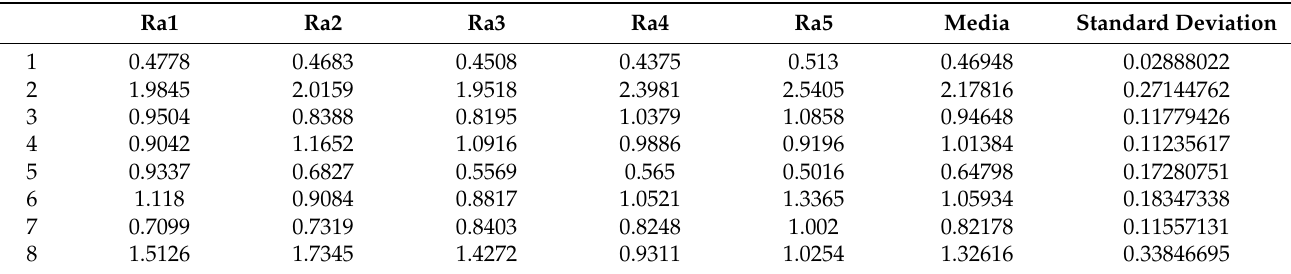
Table 3. Profilometer